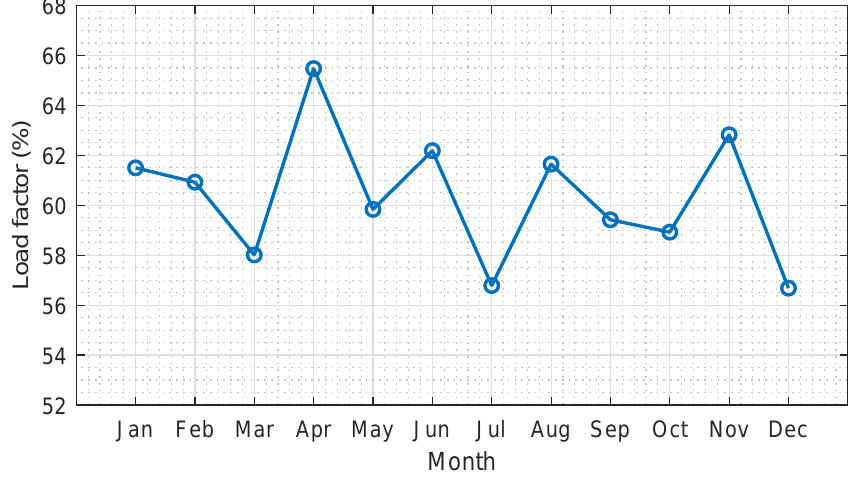
Figure 9. Variation of load factor by month.